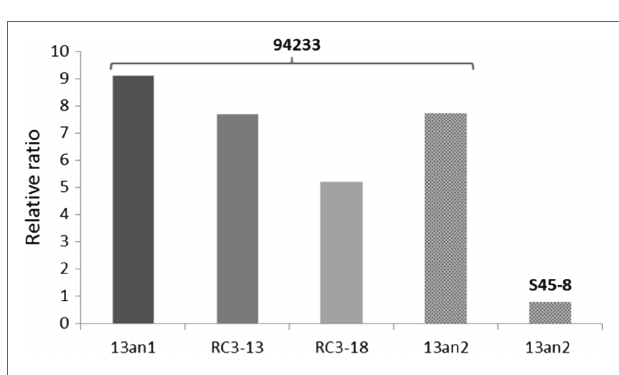
FIGURE 5 | Variation in the ratio of viral RdRp and CP in different host strains. Strains 94233 and 94233-RC3 hosted virus HetPV13-an1, and strains 94233-PV13-an2 and S45-8 hosted virus HetPV13-an2. 13an1 = HetPV13-an1 and RC3-13 = 94233-RC3 before storage; RC3-18 = 94233-RC3 after storage, 13an2 =